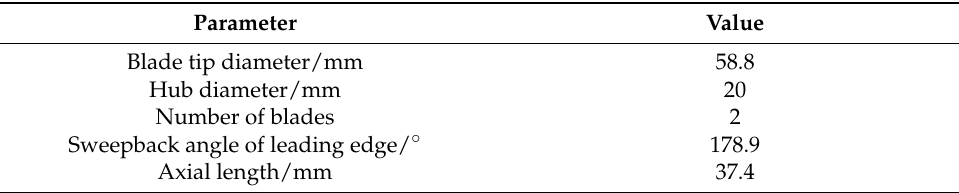
Figure 1. High-speed magnetic drive centrifugal pump. Table 1. Design parameters of the